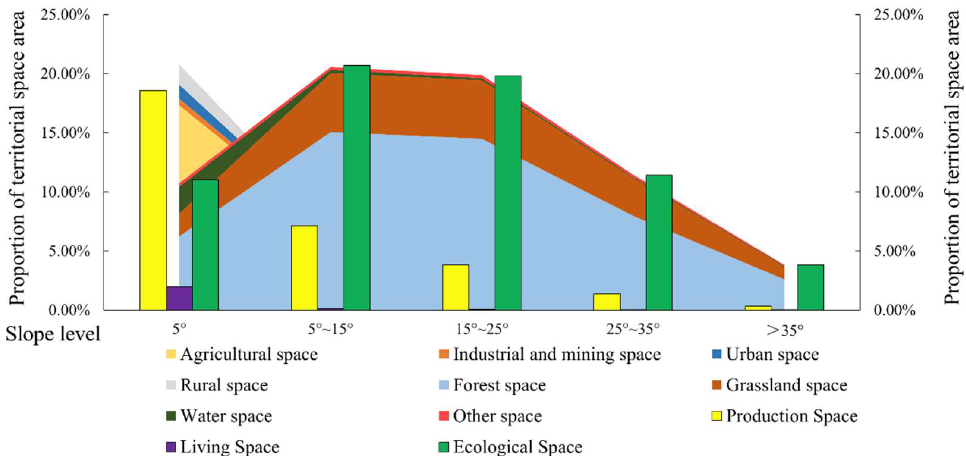
Figure 5. Proportion of territorial space area on the slope gradient of the Yangtze River Economic Belt from 2000 to 2020.